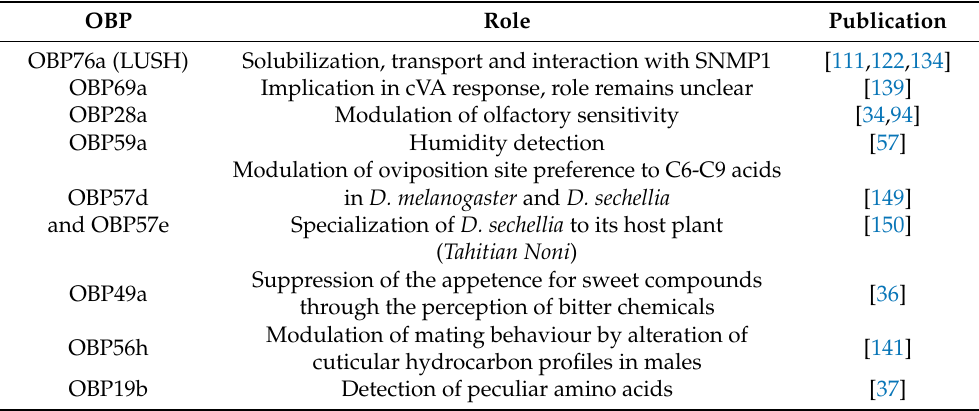
Table 2. The different roles of the OBPs in Drosophila melanogaster